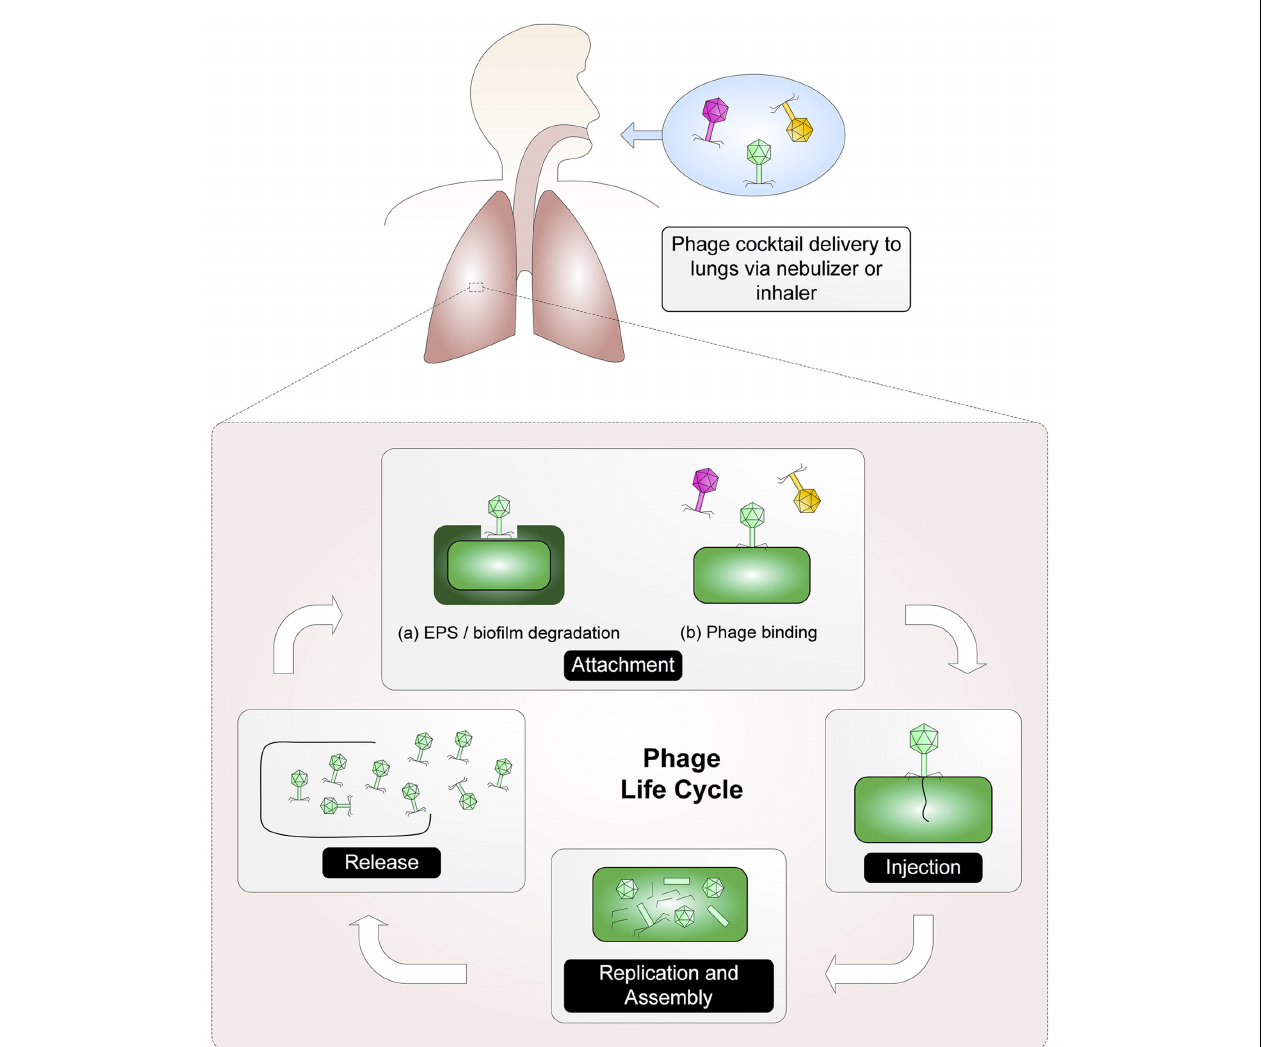
the phage are able to transfer their nucleic acid into the host. Host systems are disrupted and the replication of the phage genome begins. Once mature phage particles have been assembled, the host is lysed and the phages are